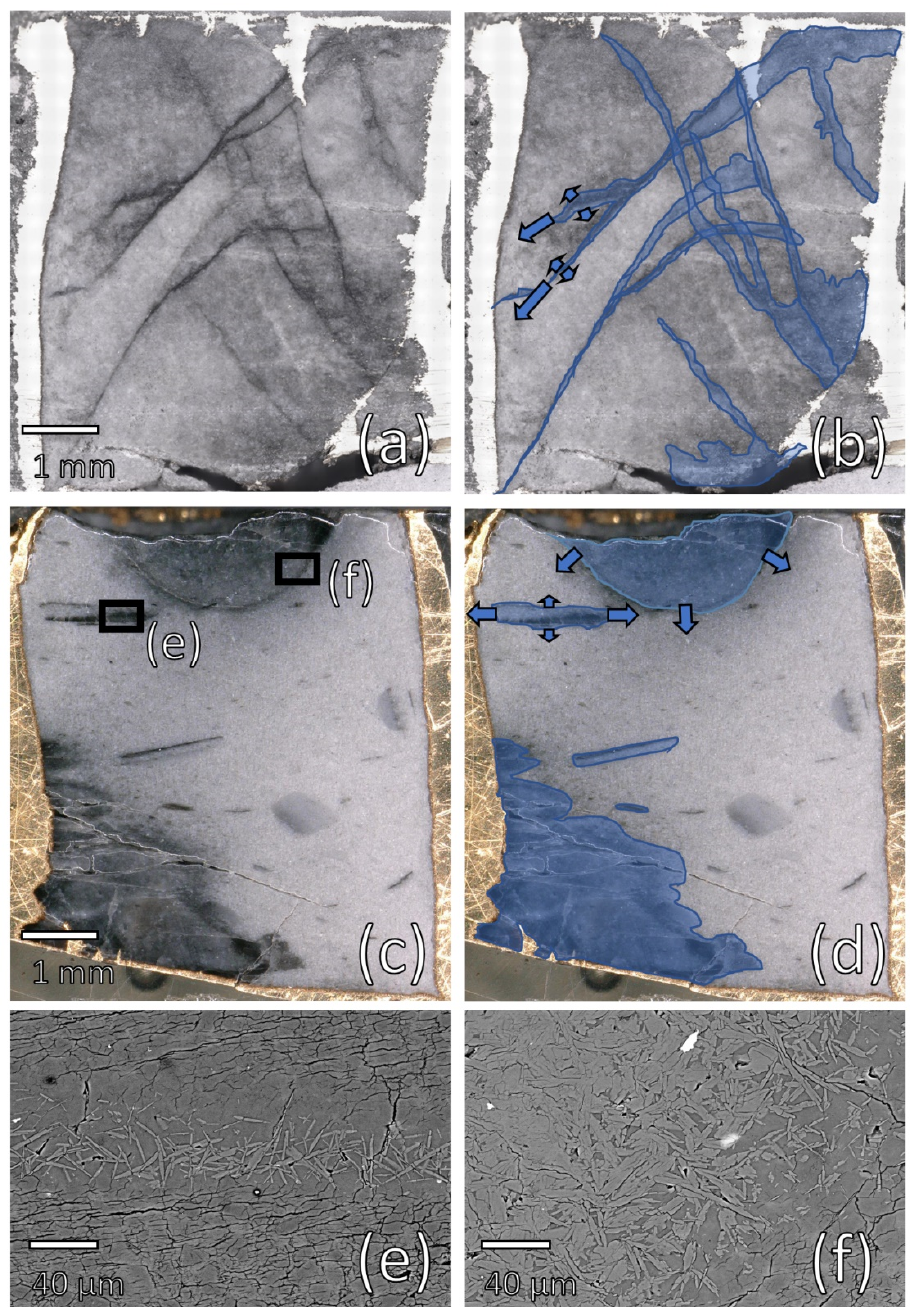
Figure 19. Microscopy images on cross sections of sample G16 ( a , b ) and a recovered quartz sample partly transformed to coesite ( c – f ) comparing modes of reaction front propagation. ( a ) Optical image, already presented in Figure 9, showing the entire sample. Ge-spinel appears darker. ( b ) Same image where the main ringwoodite-rich regions have been highlighted in blue. The narrower oblique ones correspond to shear bands and faults. Arrows schematize the fast in-plane growth of these features, relative to the sluggish plane-normal growth. ( c ) Quartz sample in its Au capsule, seen in optical microscopy. ( d ) Darker, coesite-rich, regions have been highlighted in blue. Arrows on the top reaction front show a rather isotropic growth controlled by local overpressure near the alumina piston. Arrows on the smaller coesite lens indicate preferential growth normal to principal stress. ( e ) and ( f ) Are SEM images according to the rectangles in ( c ) showing the replacement of quartz by coesite platelets and needles (brighter phase).